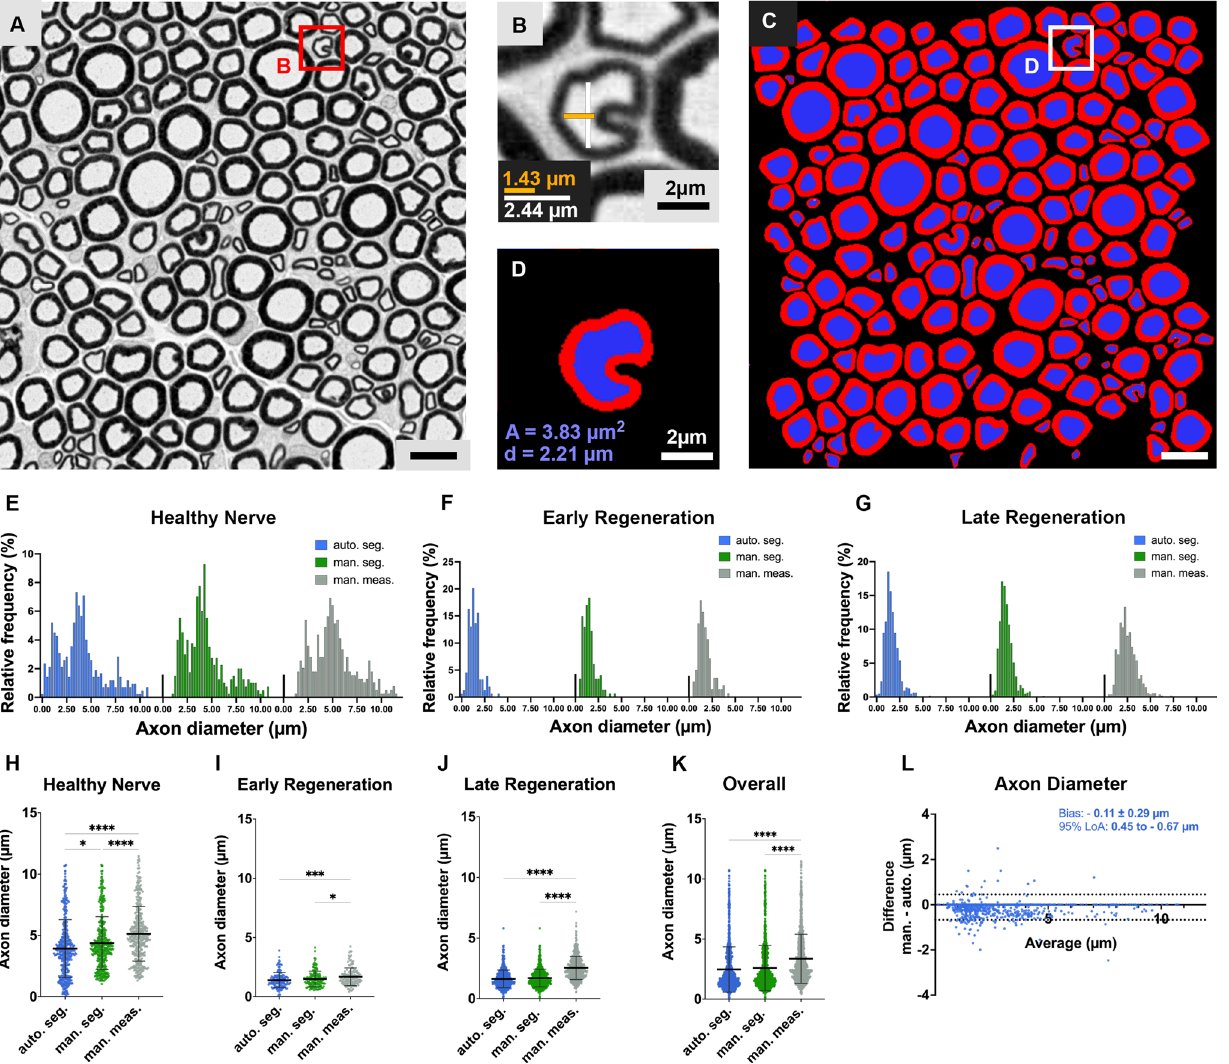
Figure 3. Automated axon diameter measurements. ( A ) Part of a cross-section of a normal rat median nerve. Myelinated axons are shown as black circles. Osmium tetroxide postfixed, epoxy embedded, 1 µm thickness, scale bar represents 10 µm. ( B ) Irregularly shaped nerve fiber. Axon diameter measurements using a straight- line technique can be unreliable as demonstrated for two different ways of measurements (orange = 1.43 µm; white = 2.44 µm) showing a 40% discrepancy. ( C ) Automated segmentation of A using AxonDeepSeg. ( D ) Automated segmentation of B. Myelin sheaths are shown in red and axons are shown in blue. To standardize axon diameter measurements, AxonDeepSeg calculates the axon diameter ( d ) from the cross-sectional area ( A ) of each axon assuming an ideal circular shape. ( E ) Histogram of the frequency distribution of nerve fibers according to their axon diameter in healthy nerves, ( F ) in early nerve regeneration stages 3 weeks post repair, and ( G ) in late nerve regeneration stages 7 weeks post repair. ( H ) Comparison of axon diameters obtained from automated segmentations (blue), ground truth labels (green) and manual morphometry (grey) for healthy nerves, ( I ) early nerve regeneration stages, ( J ) late regeneration stages and ( K ) all samples combined. When manually measured by an experimenter, the axon diameters were significantly larger compared to the ground truth histomorphometry, suggesting an observer bias towards selecting diameters that overestimate the axonal dimensions. ( L ) Nerve fiber specific comparison in a bland–Altman plot showing a good agreement of the AxonDeepSeg automated histomorphometry (auto.), with axon diameter ground truth measurements (man.). The bias represents the average of the differences and the 95% limits of agreement (LoA) comprise 95% of the differences between the two methods. (Own illustration created with